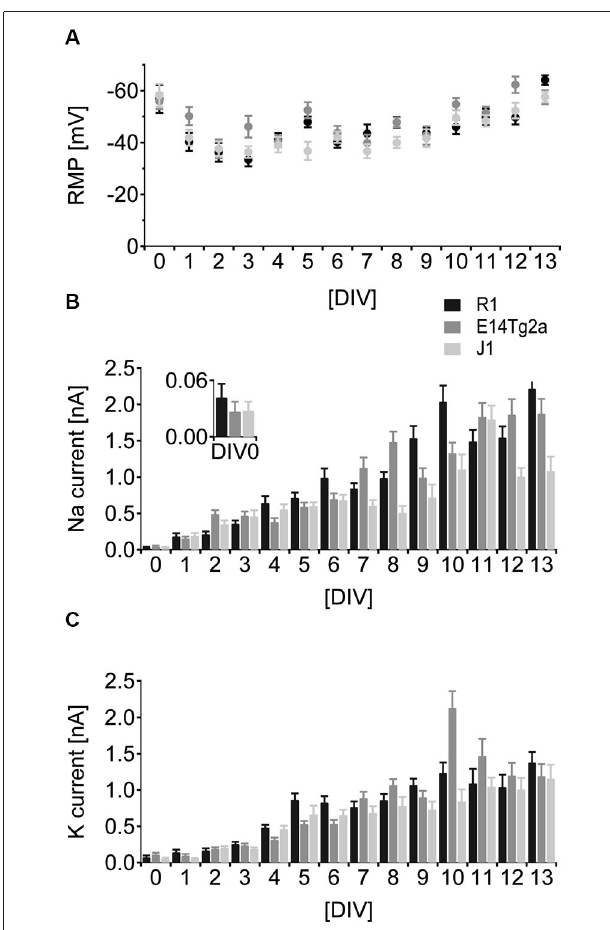
FIGURE 3 | Developmental characterization of RMP and voltage gated sodium- and potassium currents. (A) Comparison of RMP from DIV 0-13 of neurons derived from R1 (black), E14T2ga (gray) and J1 (light gray) mES cells. (B) Comparison of inward sodium currents as a function of developmental age from DIV 0-13 in neurons derived from R1 (black), E14T2ga (gray) and J1 (light gray) mES cells. (C) Comparison of outward potassium currents as a function of developmental age from DIV 0–13 in neurons derived from R1 (black), E14T2ga (gray) and J1 (light gray) mES cells.